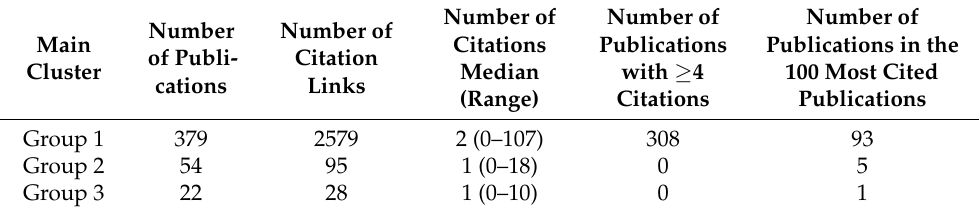
Table 9. Information about the citation networks of the three main